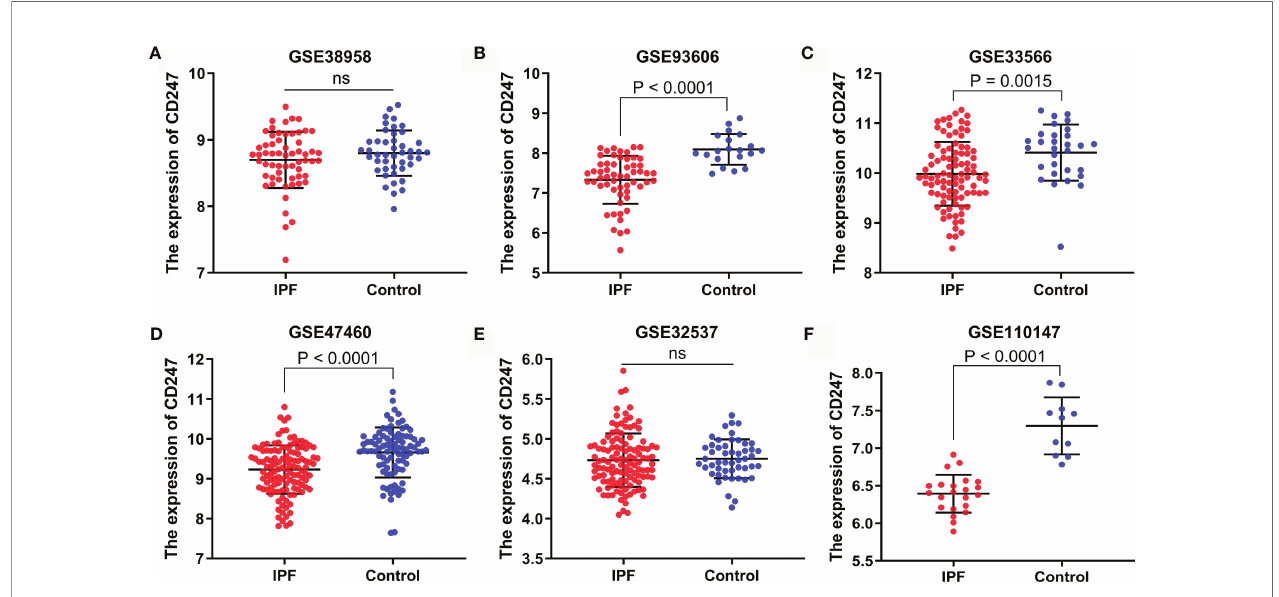
FIGURE 4 | The expression of CD247 in both blood and lung tissue. Blood: GSE38958 dataset (A) , GSE93606 dataset (B) , GSE33566 dataset (C) . Lung tissue: GSE47460 dataset (D) , GSE32537 dataset (E) , GSE110147 dataset (F) . ns, not signi fi